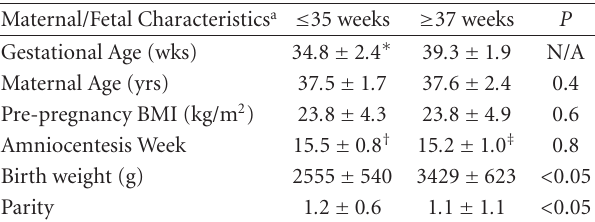
Table 1: Population